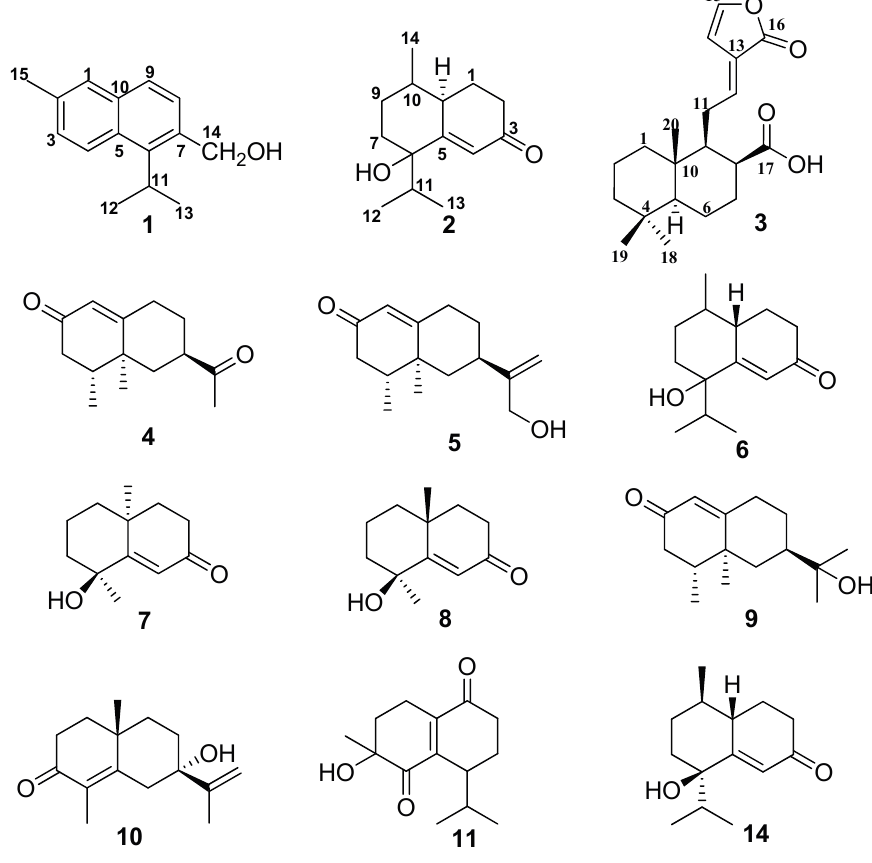
Figure 1. Compounds 1 – 11 from Alpinia Oxyphylla